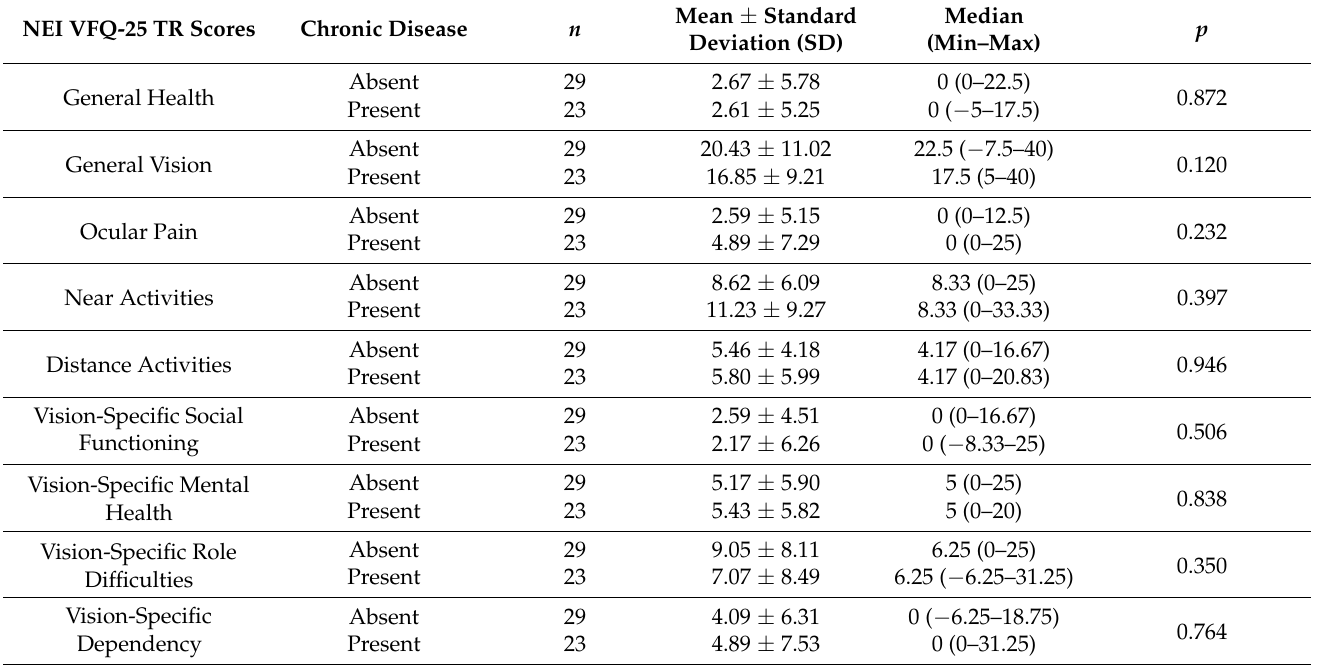
Table 7. Summary of the changes in NEI VFQ-25 TR subscale and composite scores after treatment (1 month after the third injection) according to the presence of chronic